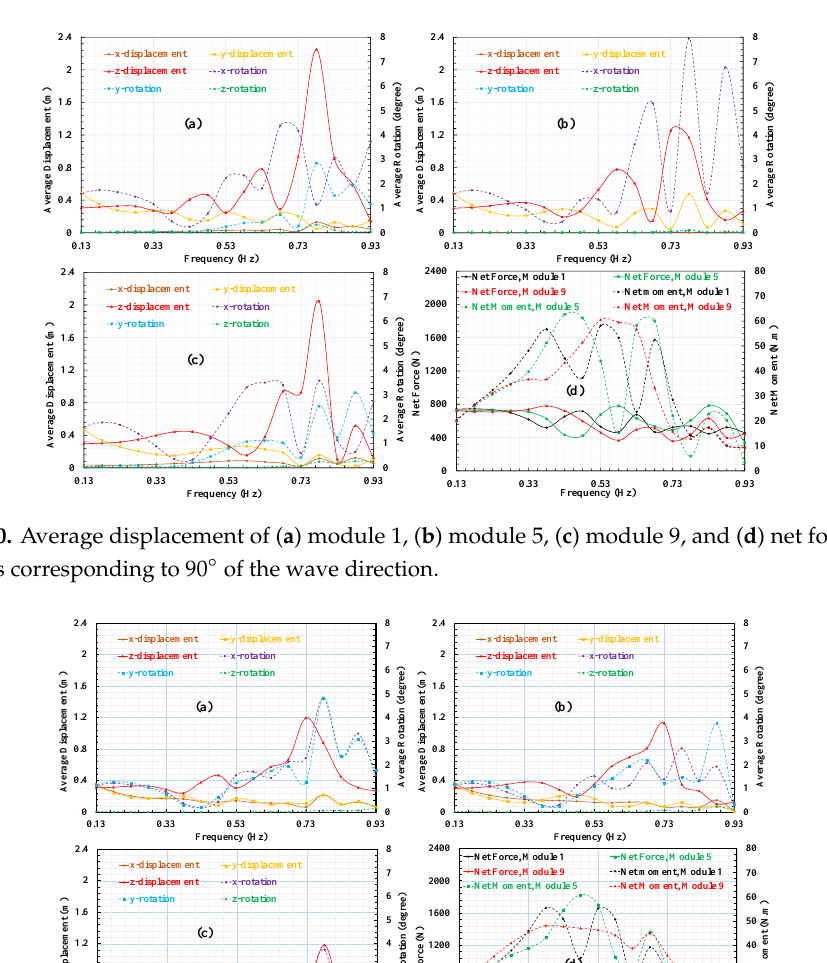
Figure 9. Average displacement of ( a ) module 1, ( b ) module 5, ( c ) module 9, and ( d ) net forces and moments corresponding to 45° of the wave direction . Processes 2020 , 8 , x FOR PEER REVIEW